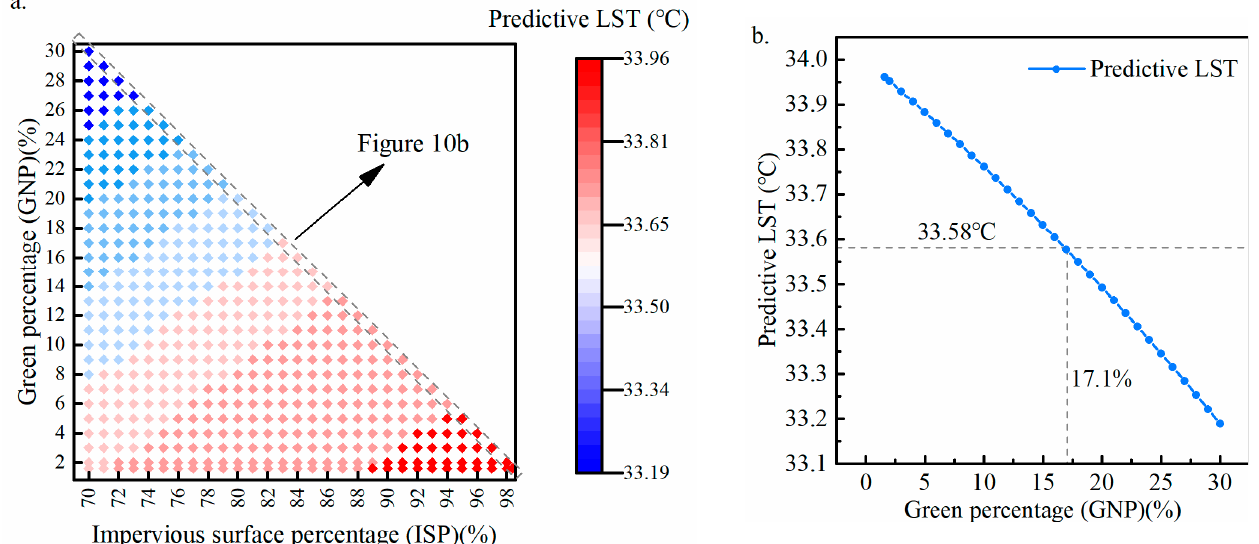
Figure 10. Distribution of predictive LST based on the FNN model: ( a ) LST matrices, ( b ) LST with GNP + ISP = 100%.